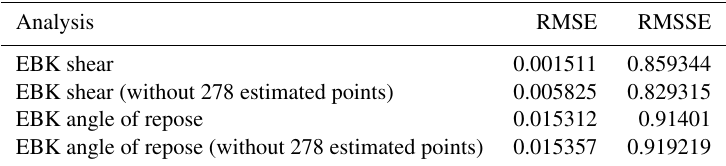
Table 3. Mean results for all points for the leave-one-out cross-validation of the EBK interpolations used in the seabed stability